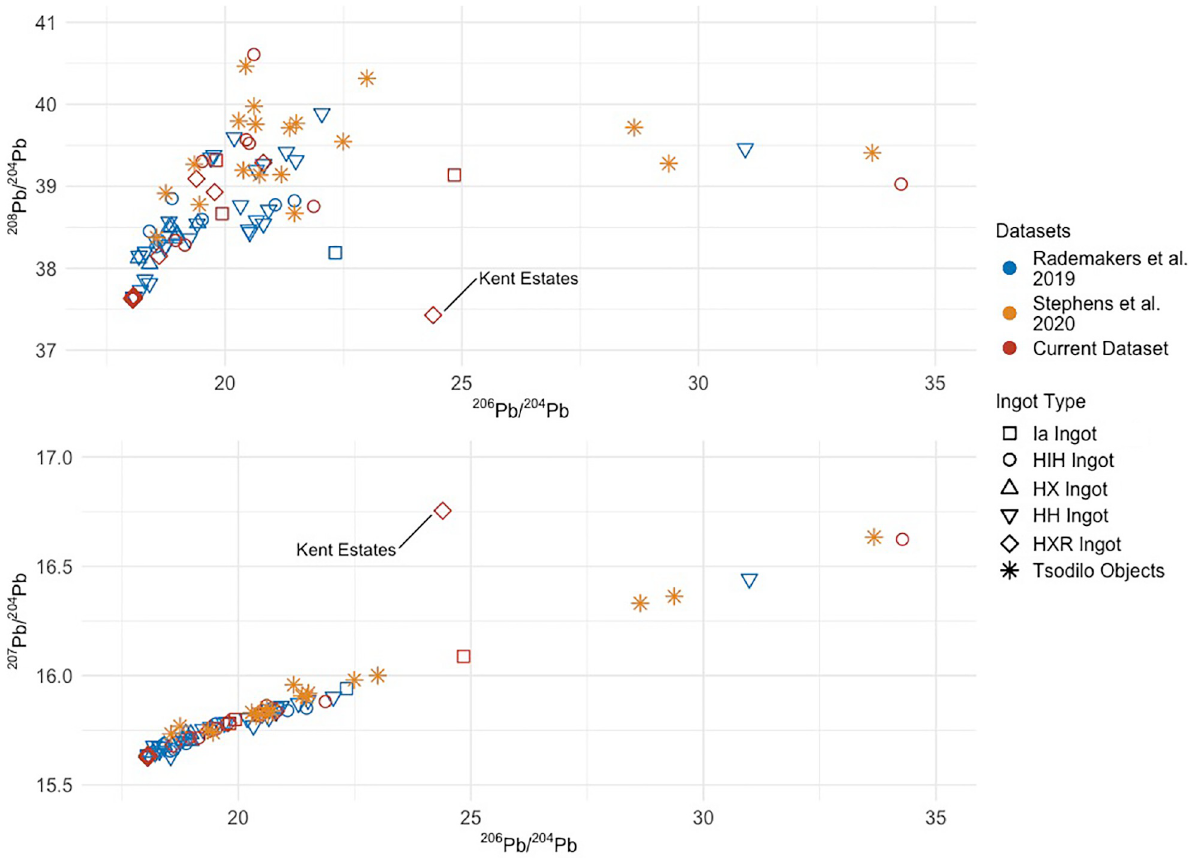
Fig 6. Comparison to existing archaeological data. Ia (rectangular and fishtail) and croisette ingot data from this study compared to ingot data from Rademakers et al. [24] on Ia (rectangular) and croisette ingots from the Upemba Depression. Results from these two projects agree well with one another and clearly illustrate that the Kent Estates HXR ingot was produced from a different geological